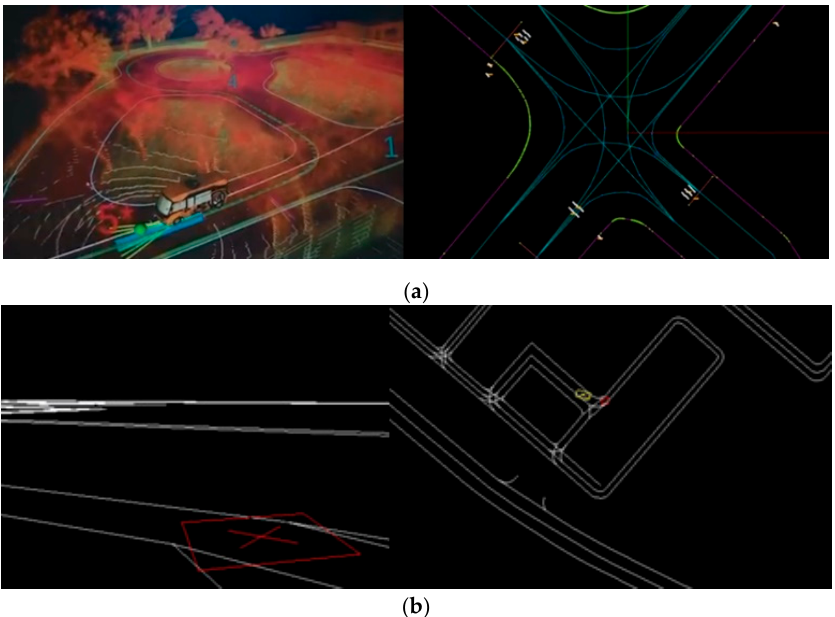
Figure 1. ( a ) Autoware HD map: (Left) 3D view; (Right) 2D view; ( b ) nVIDIA Driveworks HD map: (Left) 3D view; (Right) 2D view.